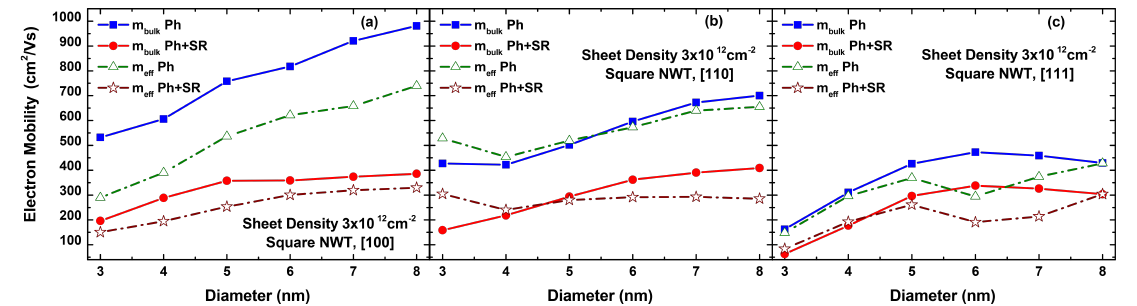
Figure 3. Electron mobility as a function of the diameter for a square nanowire with m bulk and m ef f masses and a sheet density of 3 × 10 12 cm − 2 , considering: ( a ) [100] channel orientation; ( b ) [110] channel orientation; and ( c ) [111] channel orientation. The total phonon (Ph) and the combined total phonon and surface roughness (Ph+SR) scattering effects are